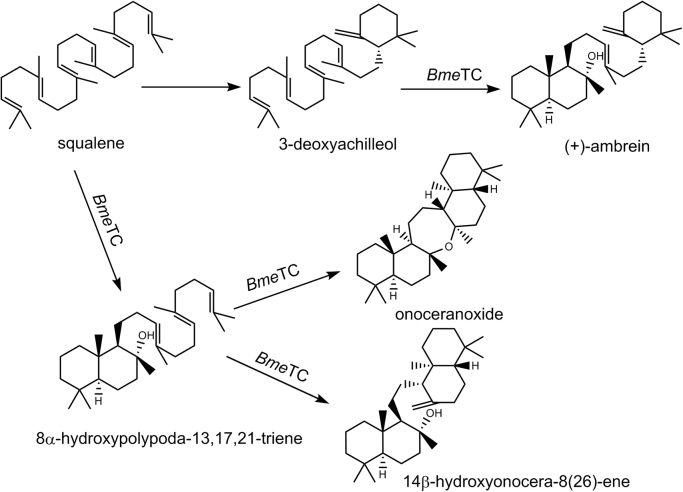
Generation of (+)-ambrein from squalene using AaSHC D377C and BmeTC according to Ueda et al. (2013).